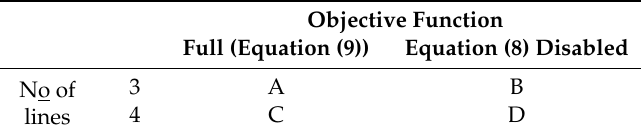
Table 6. Scheme of the optimization of lines topology.